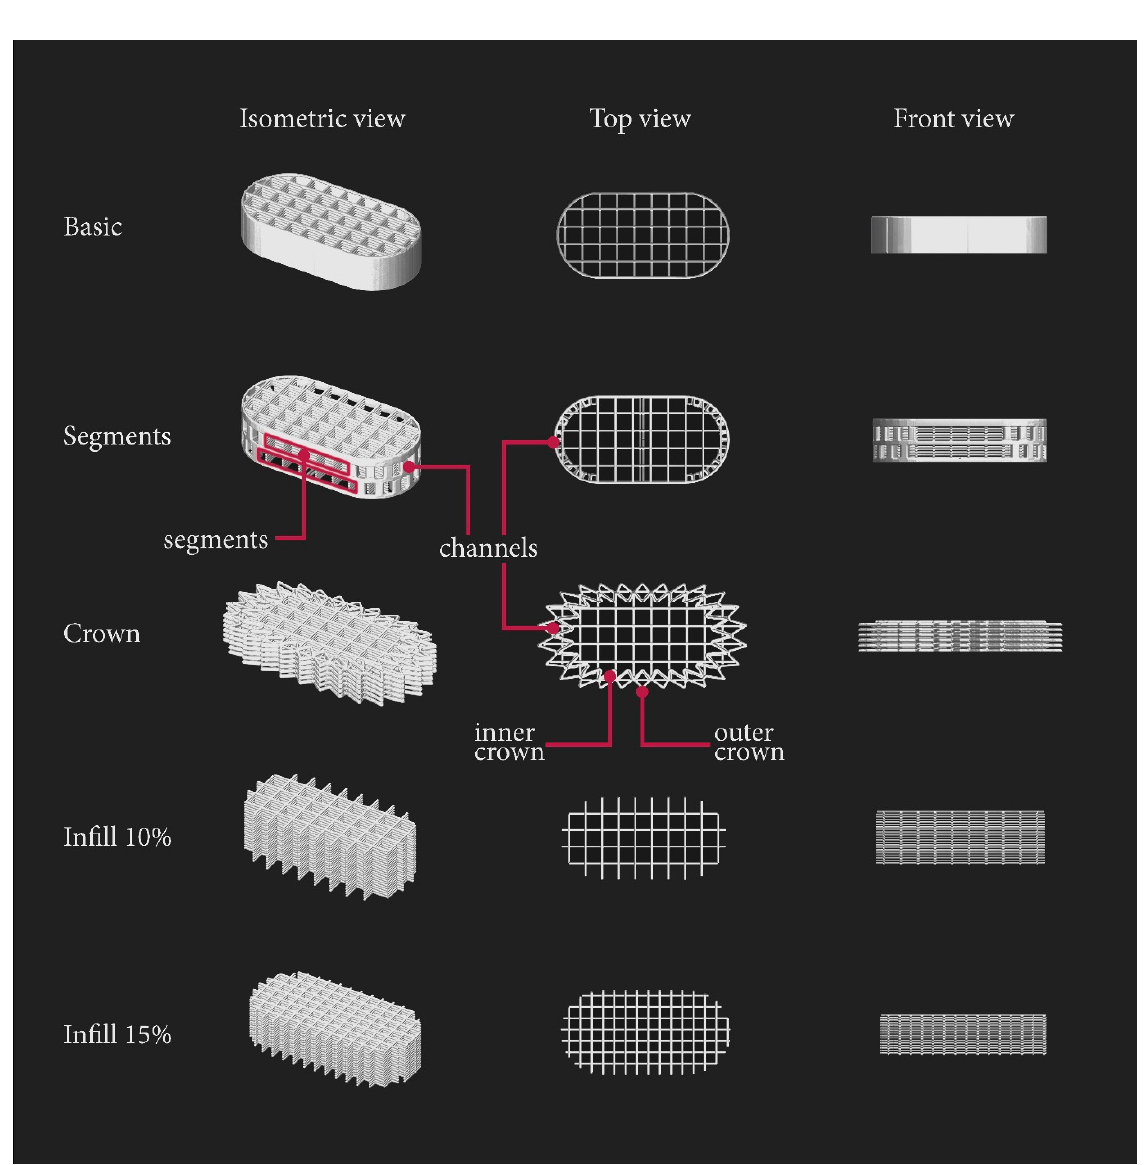
Figure 2. Designed tablets’ shapes from isometric, top, and front